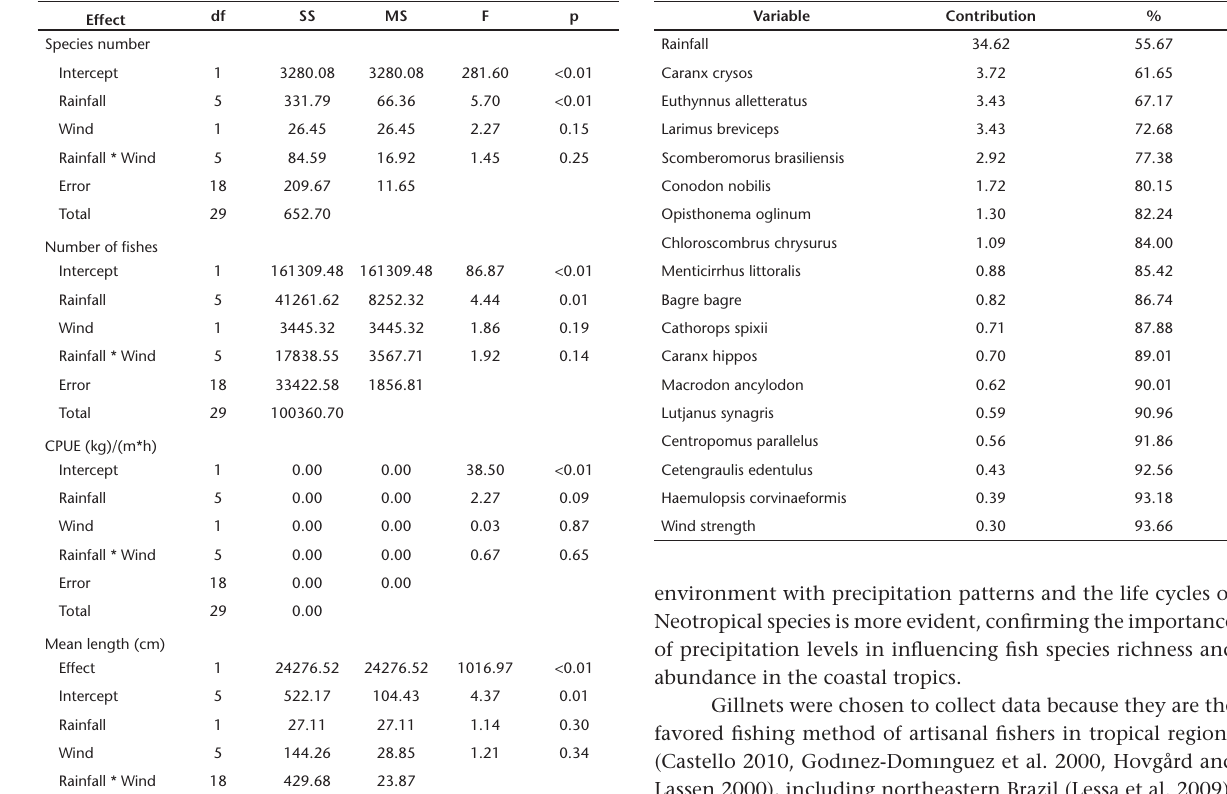
Table 3. Similarity percentage analysis (SIMPER) tested for differences in the main species composition and abiotic variables (rainfall and wind strength) at the coast of Alagoas.